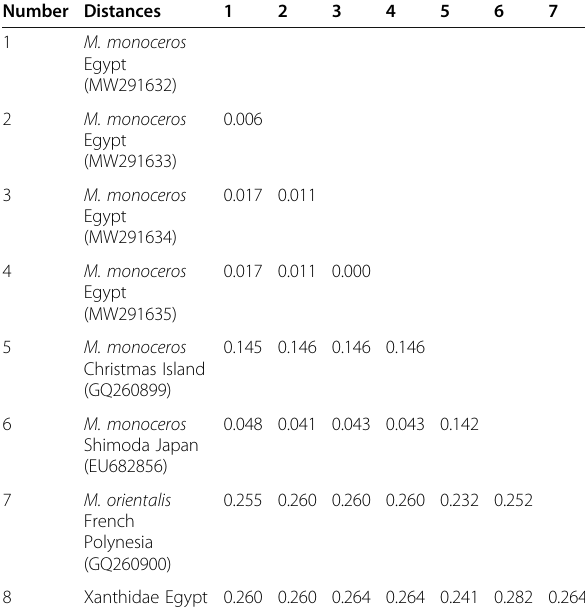
Table 3 Pairwise genetic distances between the studied specimens ’ sequences compared with the sequences obtained from GenBank COI sequences of M . monoceros